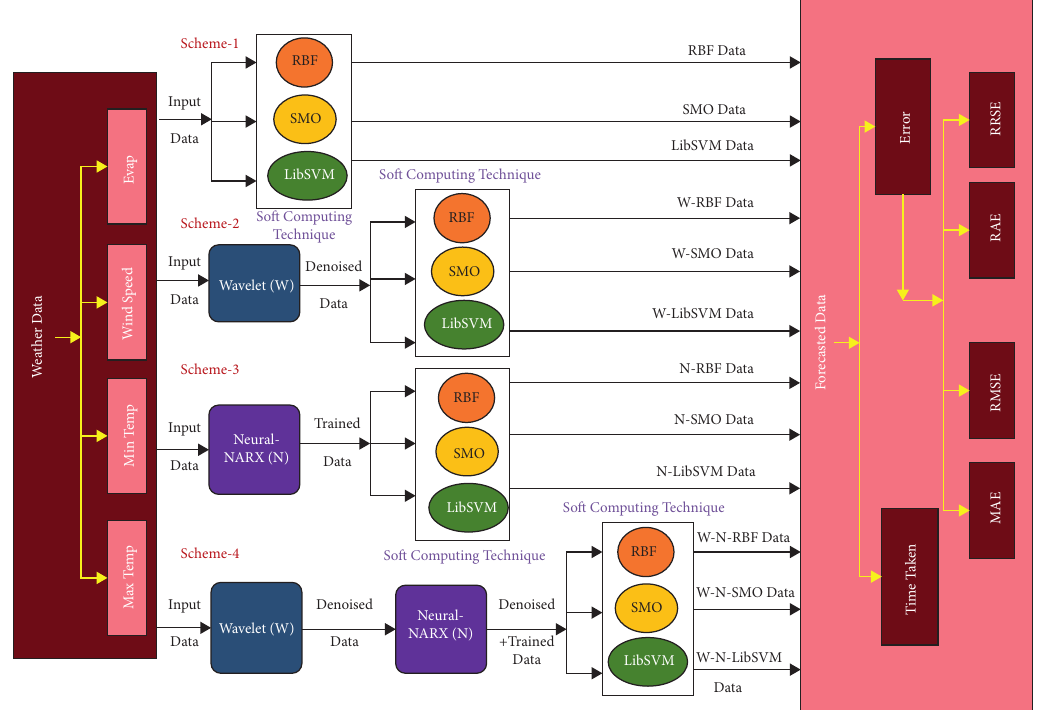
Figure 1: Flowchart for modeling of